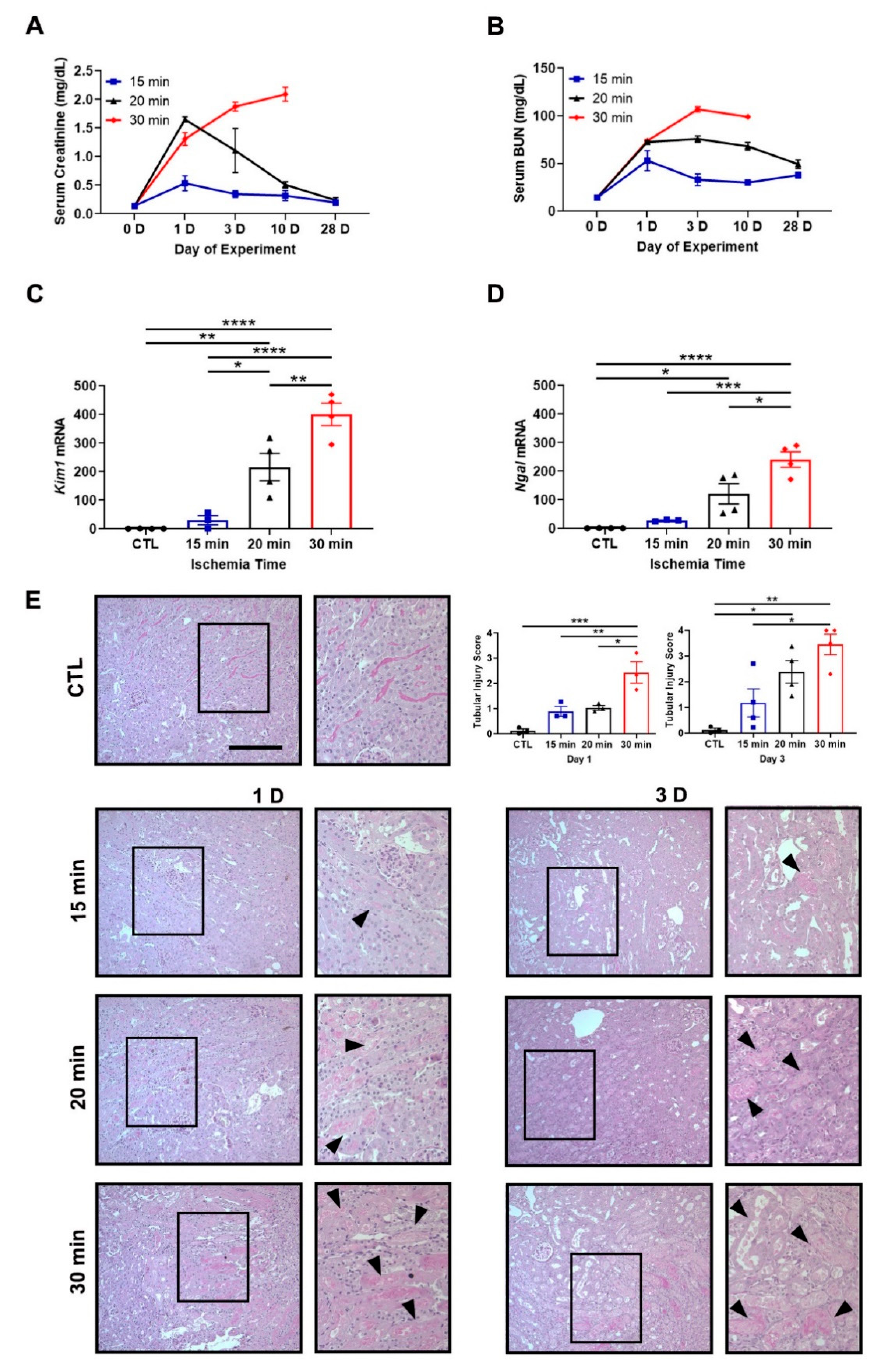
Figure 1. Ischemia time determines the magnitude of kidney injury after unilateral IRI. ( A , B ) Serum creatinine and blood urea nitrogen (BUN) levels at baseline and days 1, 3, 10, and 28. Thirty-minute ischemia leads to mice death by day 28. n = 2–4 mice/group. ( C , D ) Kim1 and Ngal mRNA expression at day 10. Kim1 and Ngal increase in the 20- and 30-min groups compared to control. The contralateral kidney from the 15-min group is used as the control. Bars are mean ± S.E.M. One-way ANOVA. * p < 0.05, ** p < 0.01, *** p < 0.001, and **** p < 0.0001. ( E ) Representative PAS-stained images are shown. Staining reveals increasing amounts of tubular damage with longer ischemia times (arrowheads). Contralateral kidney from day 1 is used as the control. Bar = 100 µ m. Enlargement of the boxed area is shown to the right of each image. Included are tubular injury score at days 1 and 3. Bars are mean ± S.E.M. One-way ANOVA. * p < 0.05, ** p < 0.01, and *** p <